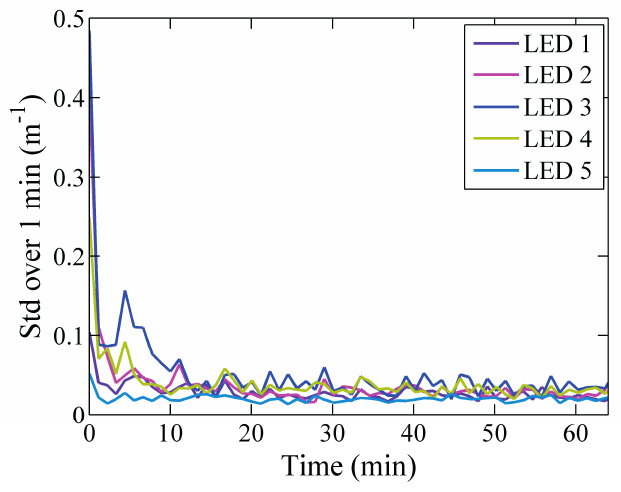
Figure 4. Stability of the VIPER output signal over one hour. Given is the standard deviation of the attenuation coefficient for 15 consecutive measurements (one min) collected in